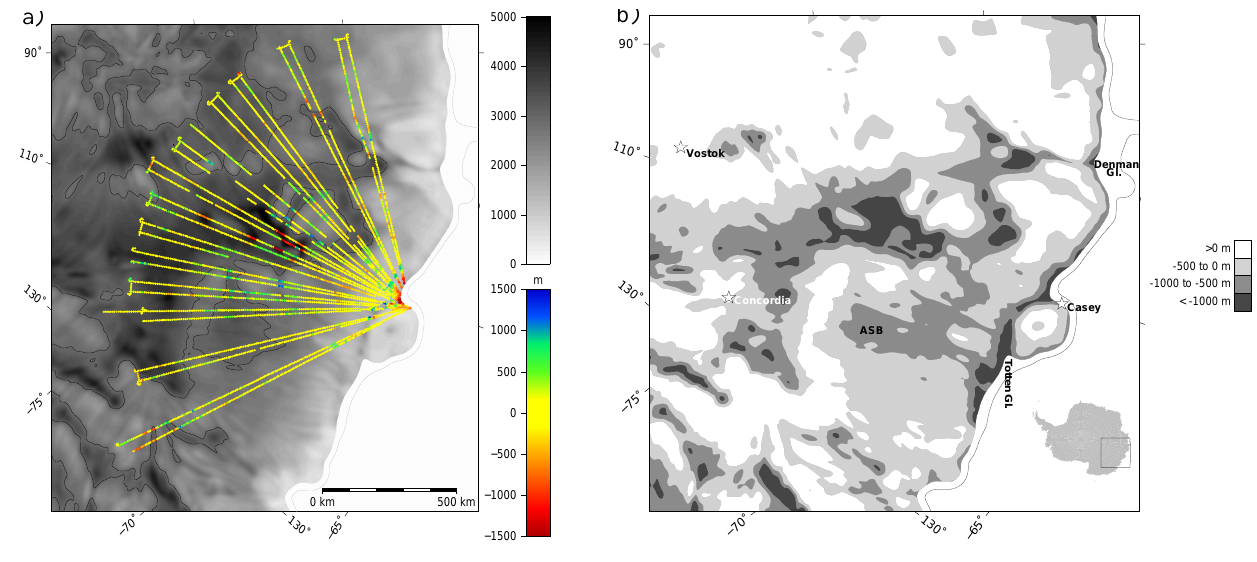
Fig. 7. (a) Smoothed TELVIS ice thickness interpolated onto a 1 km × 1km grid (gray scale), 3000 m thickness contour (black) shown for reference and thickness anomaly (measured minus calculated) along ICECAP season 1 flights (color scale). (b) Ice sheet bed elevation calculated from smoothed TELVIS ice thicknesses and a modified (see text) version of the Bamber et al. (2009) DEM.